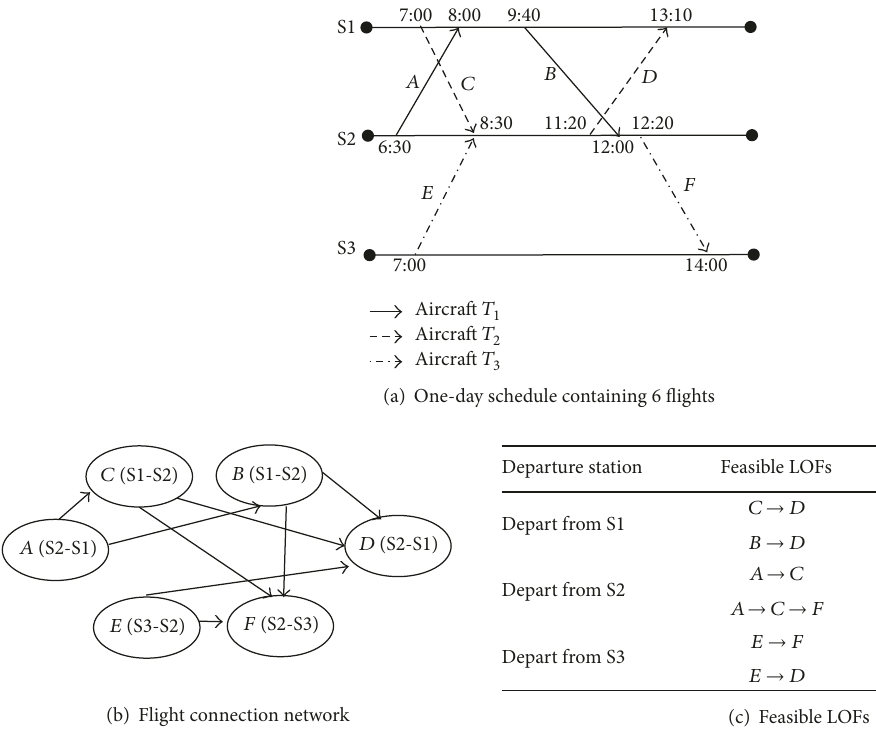
Figure 1: LOF generation without disruptions: (a) one-day schedule of three aircraft with six flights; (b) flight connection network; and (c) feasible LOFs.